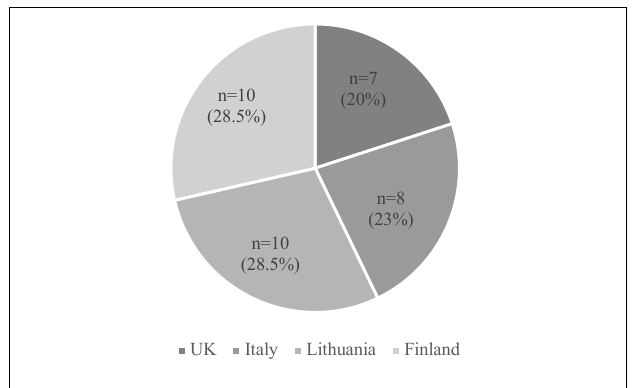
FIGURE 3 | Sample distribution per country ( N =